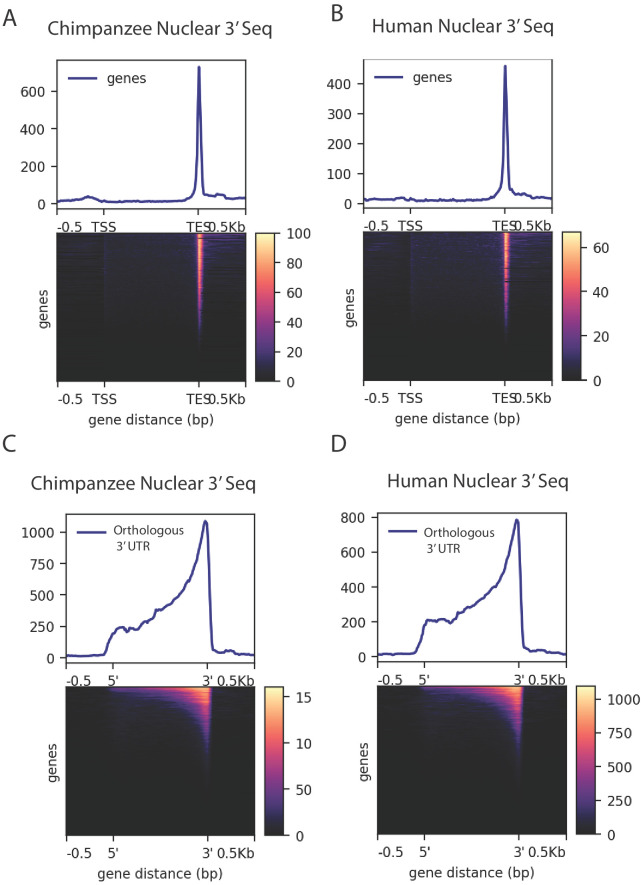
Density of merged human and chimpanzee 3' sequencing (3' Seq).(A) Coverage of six chimpanzee, nuclear 3' Seq reads along Refseq transcripts. (B) Coverage of five human, nuclear 3' Seq reads along Refseq transcripts. (C) Coverage of six chimpanzee, nuclear 3' Seq reads orthologous 3' UTRs. (D) Coverage of five human, nuclear 3' Seq reads orthologous 3' UTRs.